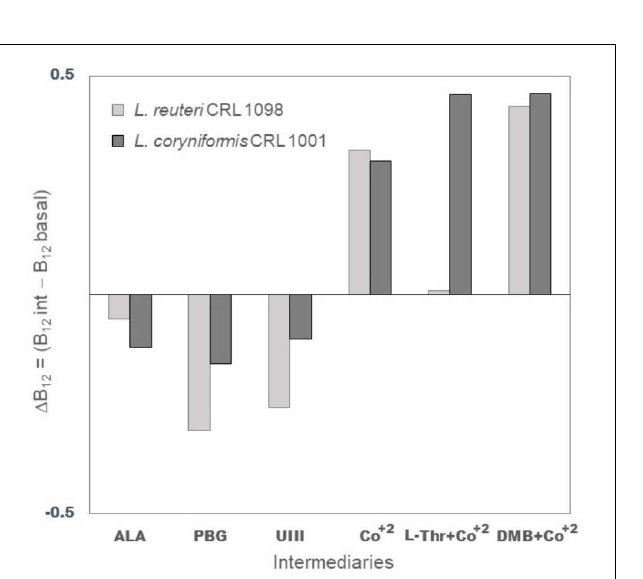
FIGURE 3 | Relative quantification of corrinoid compounds produced by L. reuteri CRL 1098 and L. coryniformis CRL 1001 with addition of different intermediaries. Results are presented as (cid:49) B 12 (net difference of the corrinoid quantification with [ B12 int. ] and without intermediary [ B 12 basal ] ). ALA (5-aminolevulinic acid), PBG (Porphobilinogen), UIII (Uroporphyrinogen III), CoCl 2 (Cobalt, Co + ), L -Thr ( L -threonine) + CoCl 2 , DMB (5,6-dimethylbenzimidazole) + CoCl 2